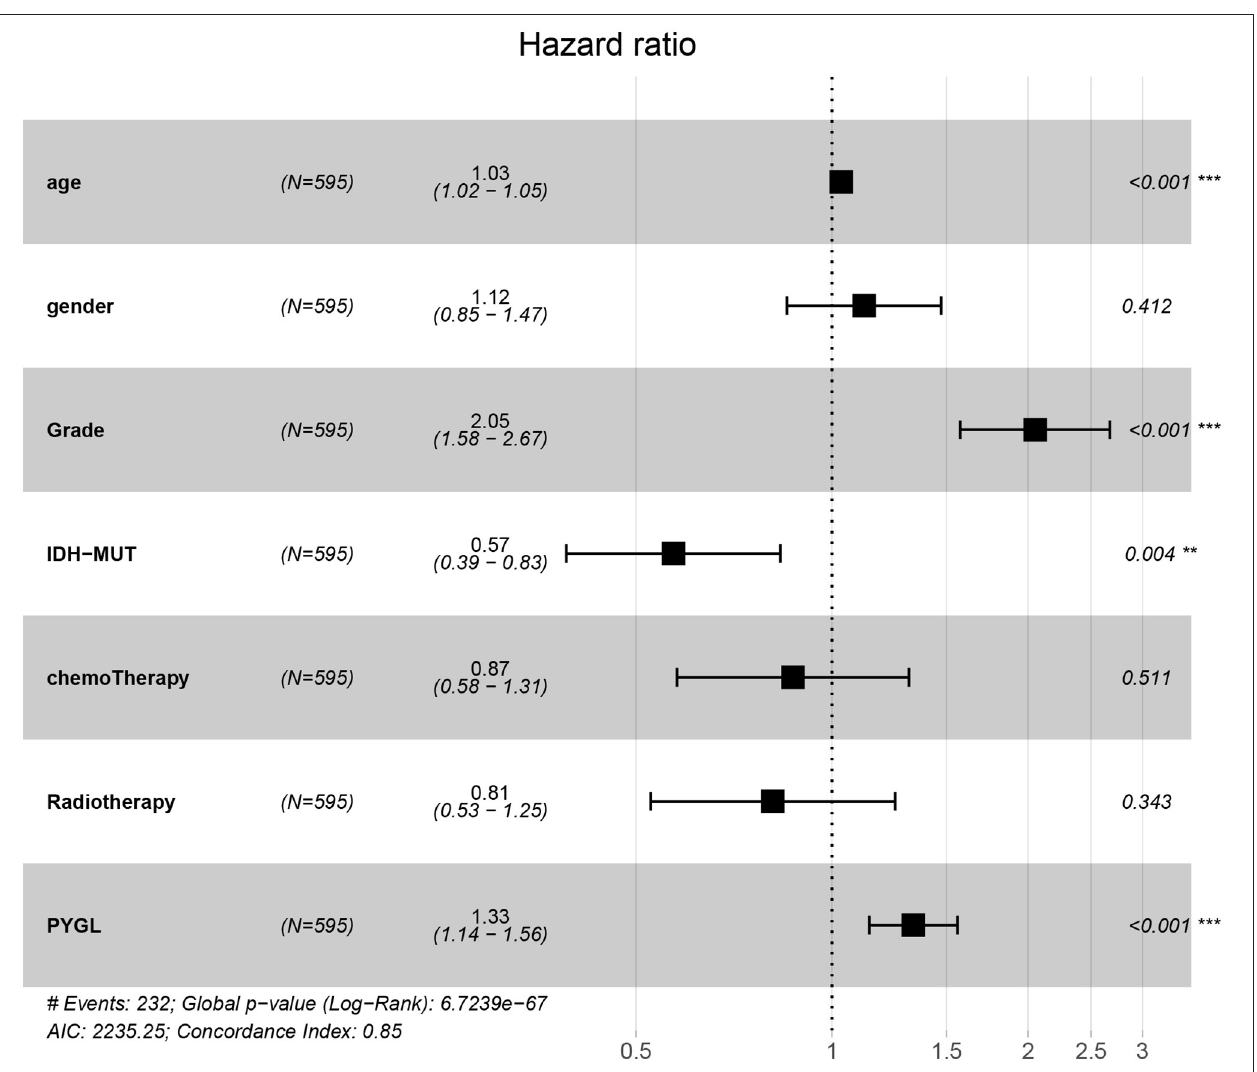
Frontiers in Neurology |